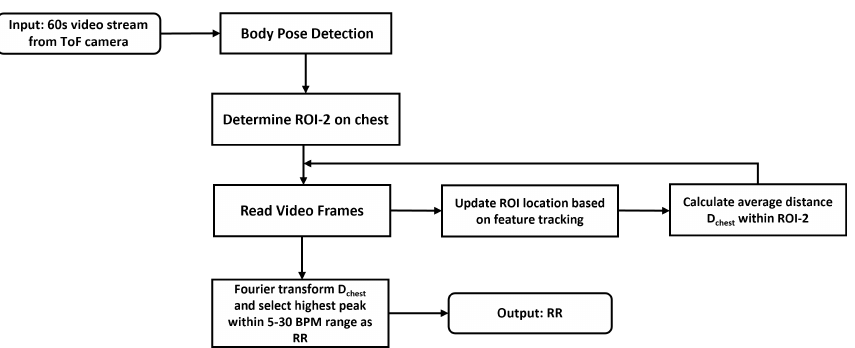
Figure 7. RR extraction process from the 3D video streams of a ToF camera.